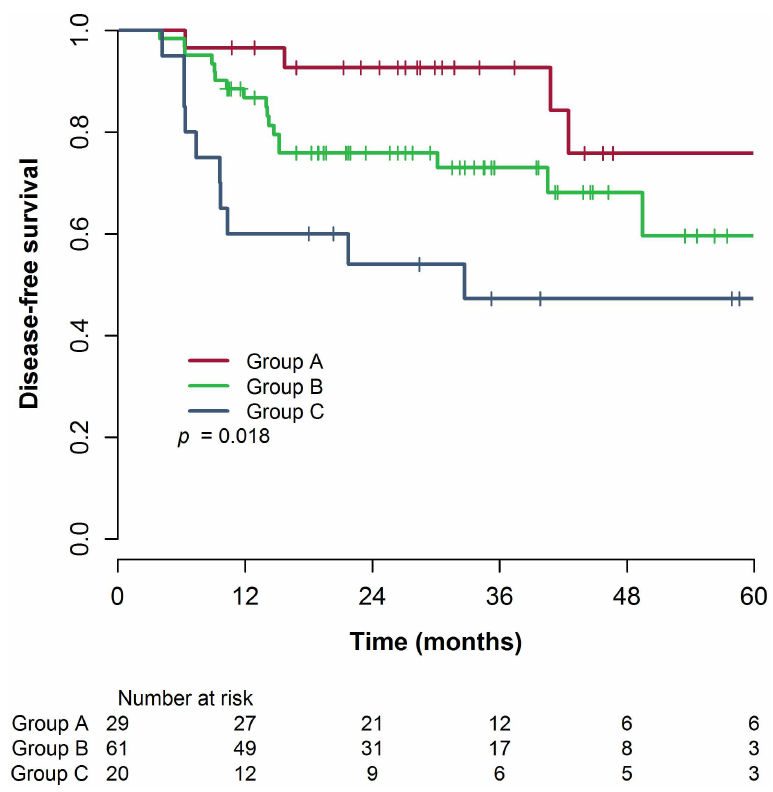
Fig 1. Disease-free survival curves based on the NLR group. Abbreviations: CRT = chemoradiotherapy, NLR = neutrophil-lymphocyte ratio, pre-CRT NLR = NLR values before preoperative CRT, post-CRT NLR = NLR values after preoperative